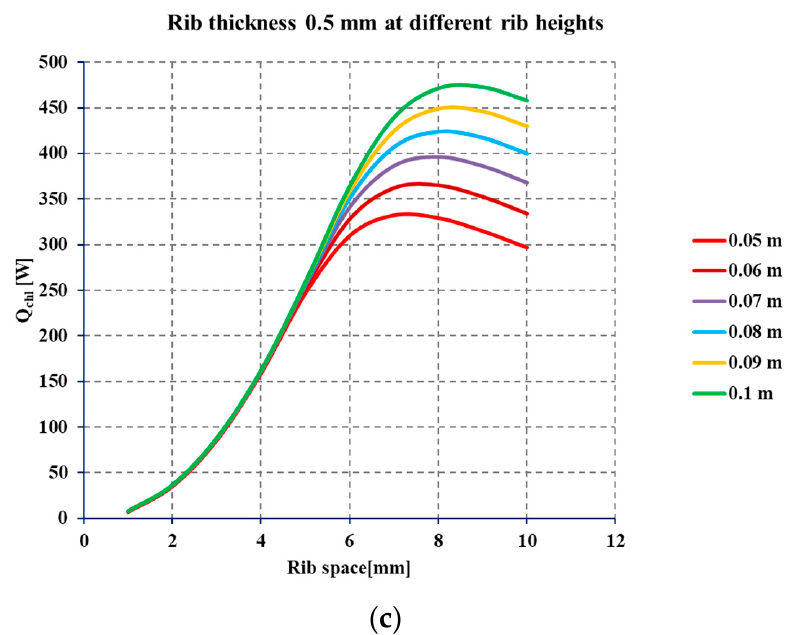
Figure 4. ( a – c ) The resulting graphs for the simulation of the cooling beam PDK-F-600-Z-2000/160, showing the power depending on the thickness, spacing and height of the ribs.